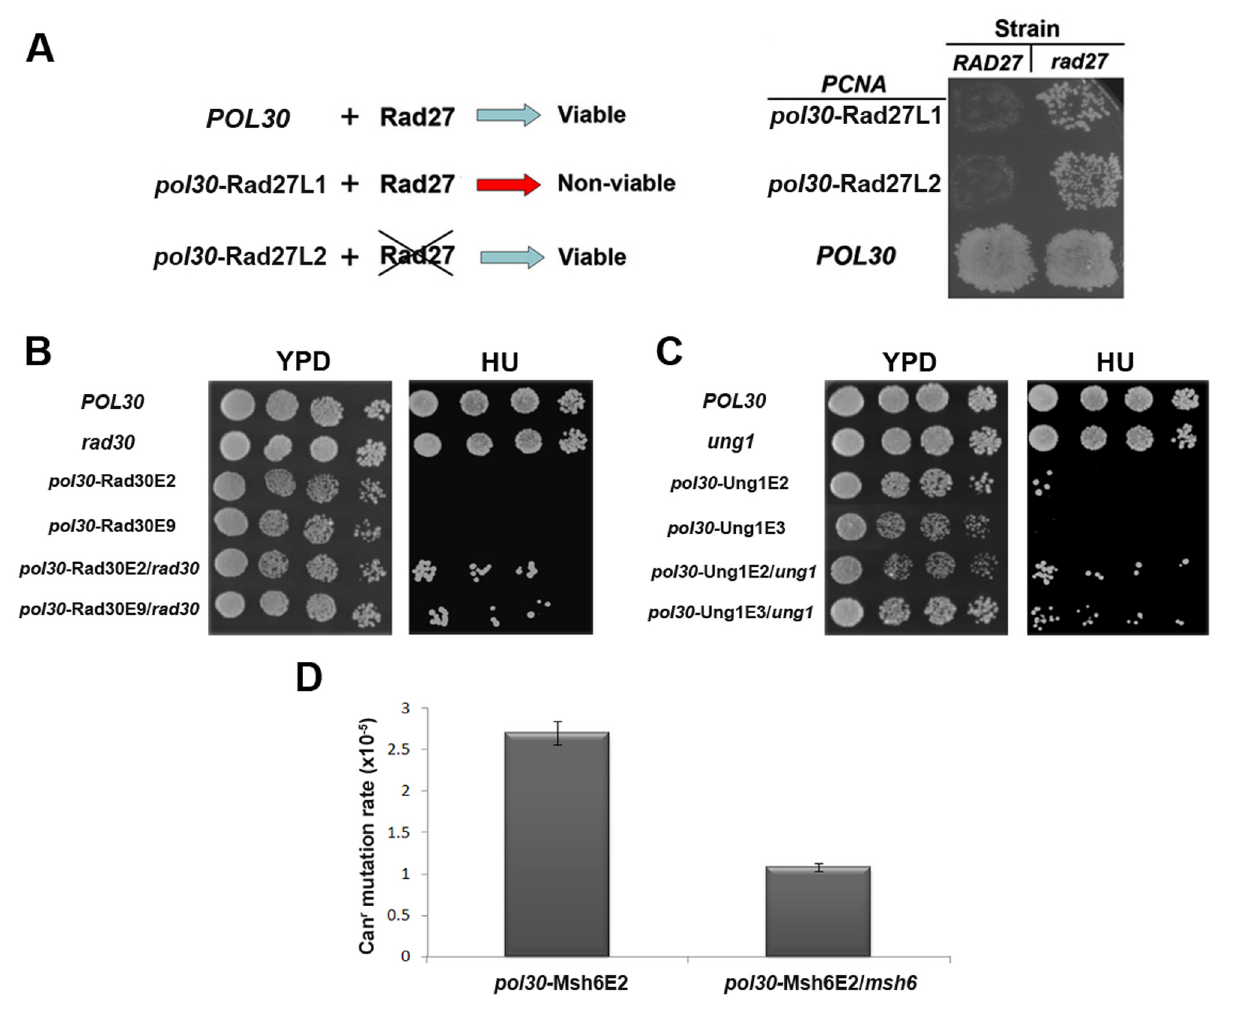
Figure 6. The suppression of pol30 mutant strain phenotypes by the deletion of PCNA partner-encoding genes. (A) Lethality in yeast strains containing PCNA mutants with increased affinity for Rad27 can be suppressed by rad27 deletion. General scheme describing the suppression of lethality (left). The growth analysis of pol30 mutant and WT strains generated on the background of the parent or rad27 -deleted strain (right). Strains containing each PCNA mutant as a sole source of PCNA were generated by transformation with a URA3 -marked plasmid containing the POL30 gene and a LEU2 -marked plasmid containing pol30 -Rad27L1, pol30 -Rad27L2, or POL30 (used as a control), followed by plating onto 5-FOA to force the loss of the URA3 plasmid (see Materials and Methods for detailed description). (B,C) The suppression of pol30 -Rad30E2, pol30 -Rad30E9 (B), pol30 - Ung1E2, and pol30 -Ung1E3 (C) strain growth sensitivity phenotypes by rad30 (B) or ung1 deletion (C). POL30 and the pol30 mutant strains were generated and examined as described above. (D) Suppression of the level of spontaneous mutation rate of the pol30 -Msh6E2 mutant strain by msh6 deletion.